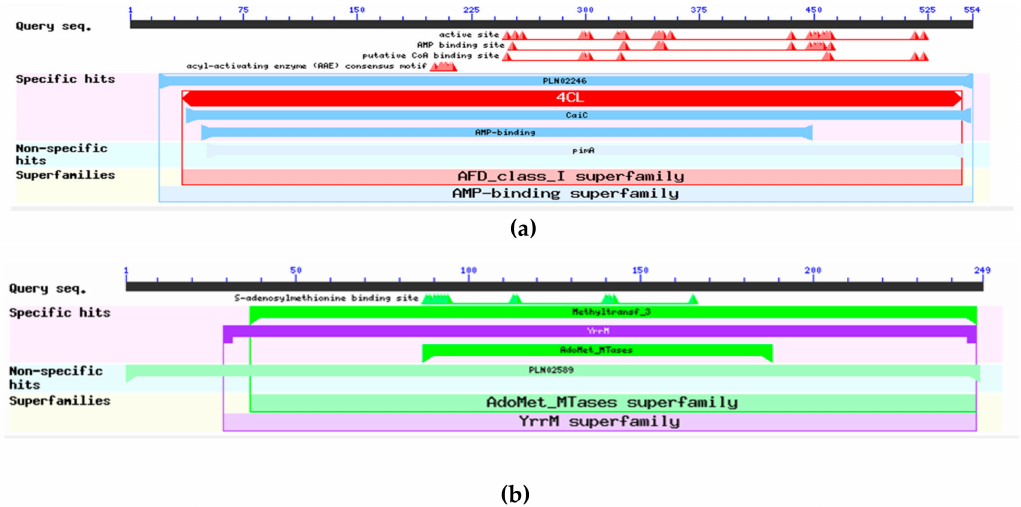
Figure 5. Protein domain analysis of Cf4CL ( a ) and CfCCoAOMT ( b ) proteins in C. fortunei . The figure was constructed with NCBI conserved domains. Specific hits are the top-ranking RPS-BLAST hits (compared to other hits in overlapping intervals) that meet or exceed a domain-specific E-value threshold (details and illustration). Non-specific hits meet or exceed the RPS-BLAST threshold for statistical significance. Superfamily is the domain cluster to which the specific and / or non-specific hits